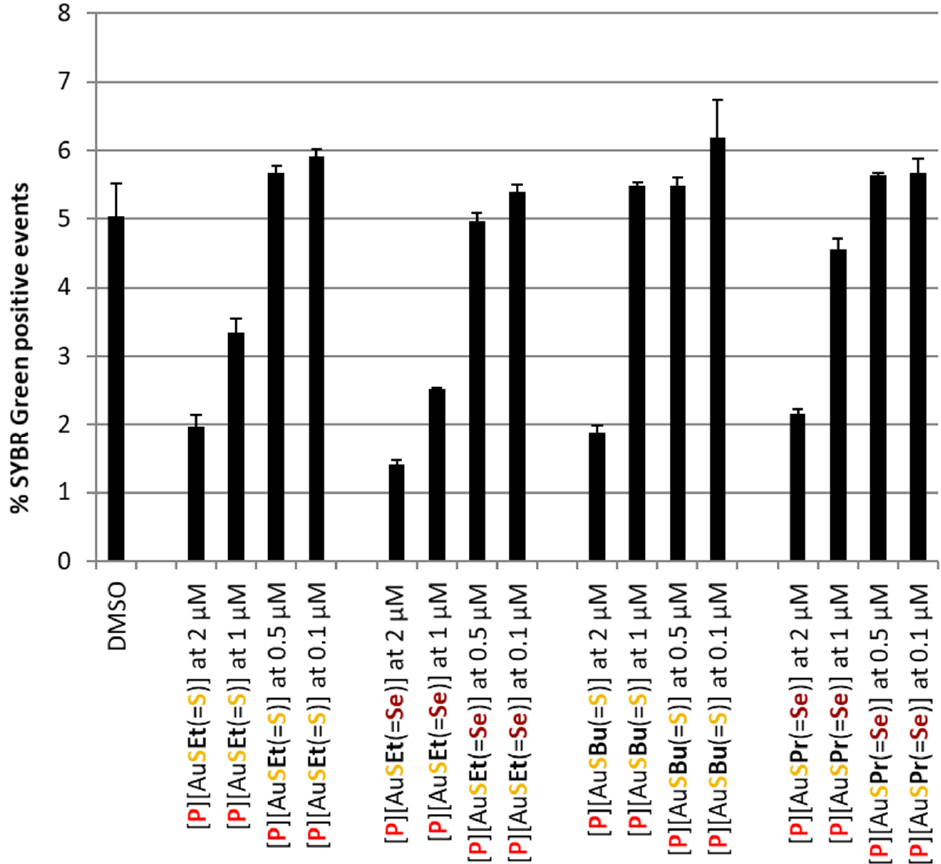
Figure 5. Assessment of the in vitro activity of selected Au(III) bis(dithiolene/diselenolene) complexes against the blood stage of P. falciparum NF54 infection. Infection was assessed by flow cytometry as the percentage of SYBR green positive events. A percentage of DMSO equivalent to that present in the highest compound concentrations was employed as a negative control. Results are represented as mean ± SD, n = 1. Table 3. IC 50 values of selected Au(III) bis(dithiolene/diselenolene) complexes against the hepatic stage of P. berghei and the blood stage of P. falciparum NF54 for selected complexes.